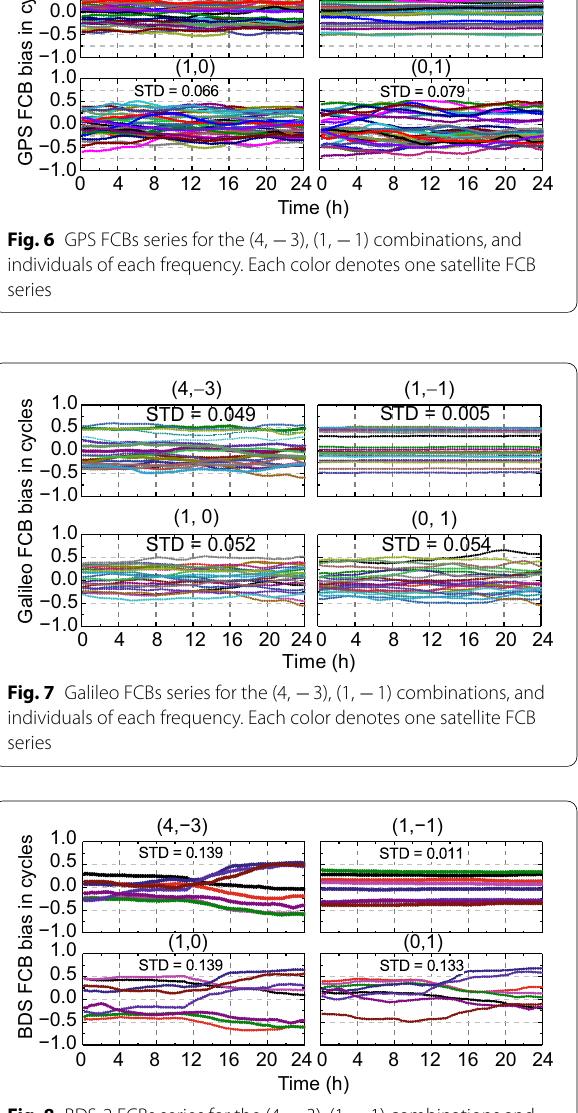
3), (1, 1) combinations and − −